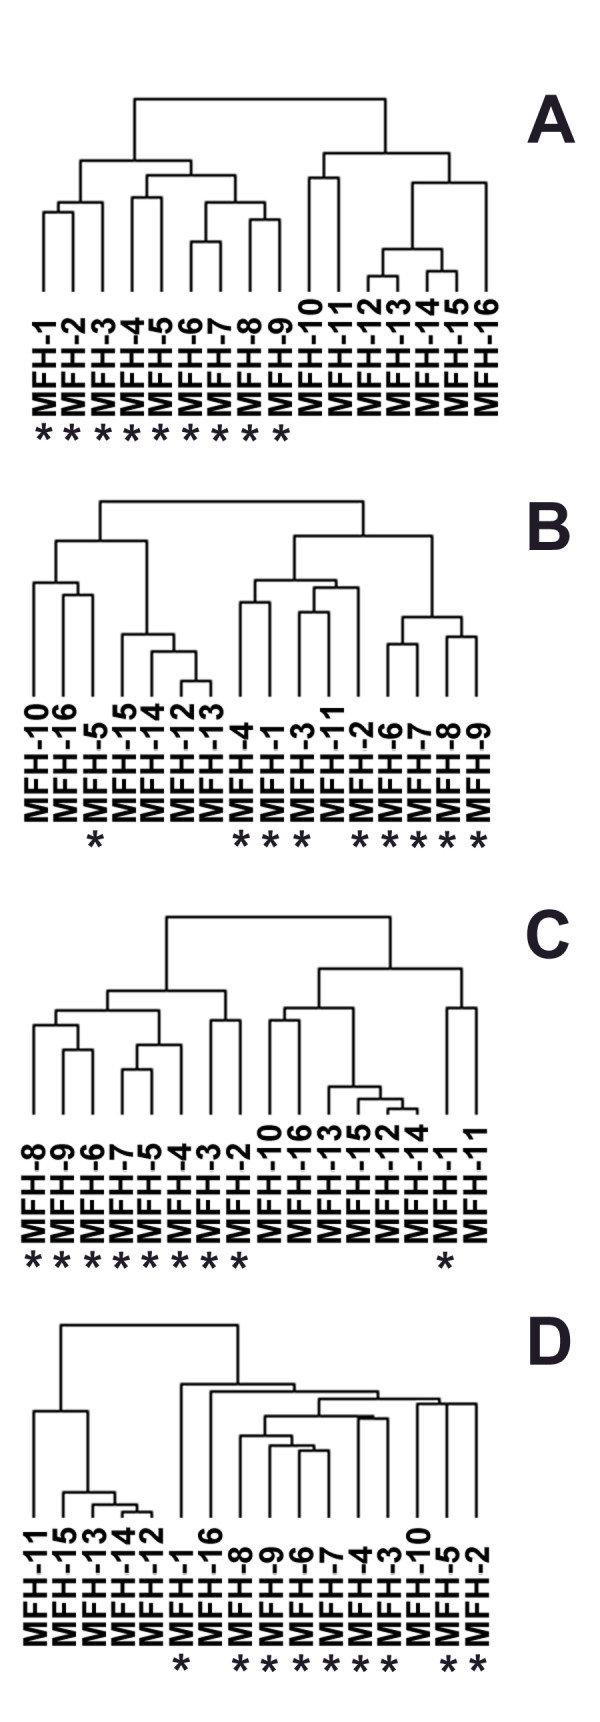
Clustering of gene expression of the MFH samples with the RCC gene set (A), OVCA gene set (B), AF gene set (C), and the protein kinase gene set (D) as described in the text. The 16 MFH samples were clustered using the Eisen clustering software Cluster as described in the text. MFH-1 to MFH-9 grouped together in panel A and are indicated by an asterisk. The tissue samples in the tree are joined by very short branches if they have gene expression patterns that are very similar to each other, and by increasingly longer branches as their similarity decreases.